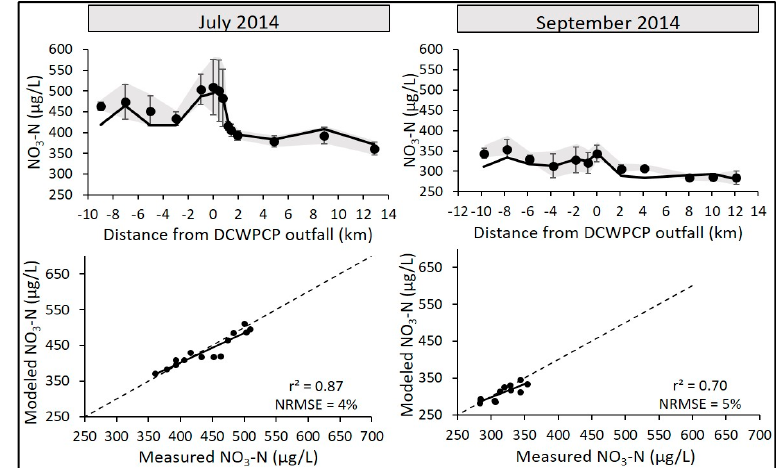
Figure 7. Top panels : comparison of transect-mean nitrate concentrations (see Figure 3 for transects) for model results and measurements on 19 July and 9 September 2014. The transect means are calculated as the means of the vertically averaged concentration at each transect station. Bottom panels : 1:1 comparison of model results from run#1 to measurements. Solid black lines indicate the best fit between model and data. Dashed lines are a diagonal representing a perfect match. Coefficient of determination ( r 2 ) and normalized root-mean-square error (NRMSE) between model results and measurements were estimated at a significance level of p = 0.05. Model results are from run#1.